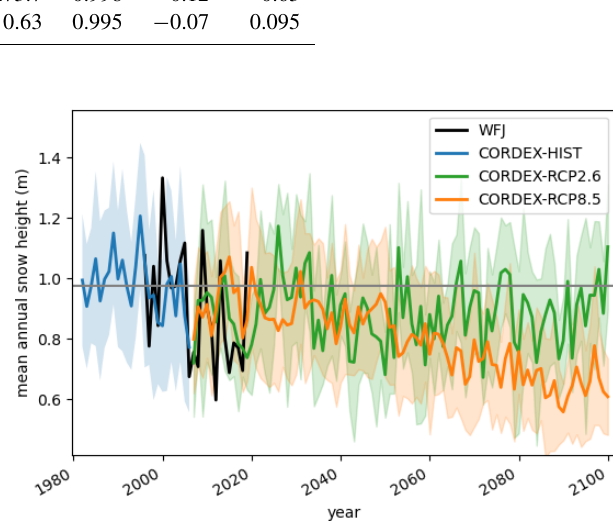
Figure 5. An example of a point-scale TopoCLIM product: the mean annual snow depth (m) ensemble at the Weissfluhjoch station (2540ma.s.l.) for historical and future RCP scenarios. Observations from Weissfluhjoch are given in black for a qualitative comparison. Ensemble means are indicated by solid lines, and the long-term av- erage over the plotted historical period (1981–2010) is given by the horizontal line. Observations lie within the ensemble spread, indi- cating that the bias correction method works satisfactorily. It should be stressed that we do not attempt a quantitative comparison here, as the variability of CORDEX (and climate models more generally) is not expected to be perfectly synchronized with the observed vari- ability. Nonetheless, this representation usefully shows the inter- annual variability present in both the model and the observations instead of simply showing decadal